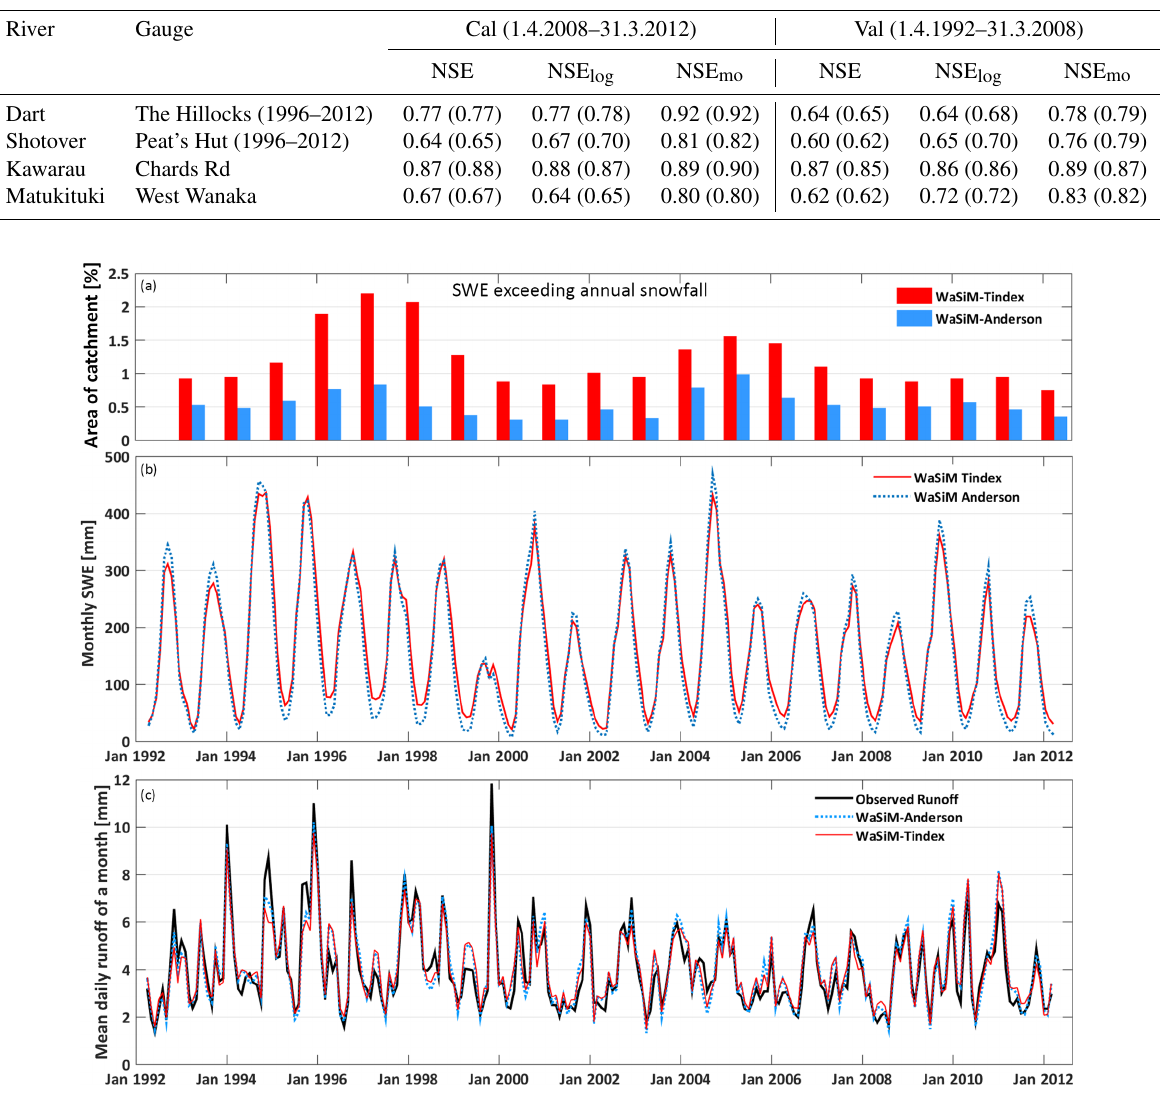
Figure 3. (a) Relative area of the Kawarau catchment where SWE exceeds annual snowfall for a hydrological year (e.g. 1 April 1992– 31 March 1993) as an indicator for unrealistic build-up of snow (i.e. snow towers). (b) Modelled mean monthly snow water equivalent (SWE) based on the Tindex and Anderson simulations. (c) Observed and modelled (WaSiM-Anderson and WaSiM-Tindex) monthly runoff at Chards Rd for the reference period